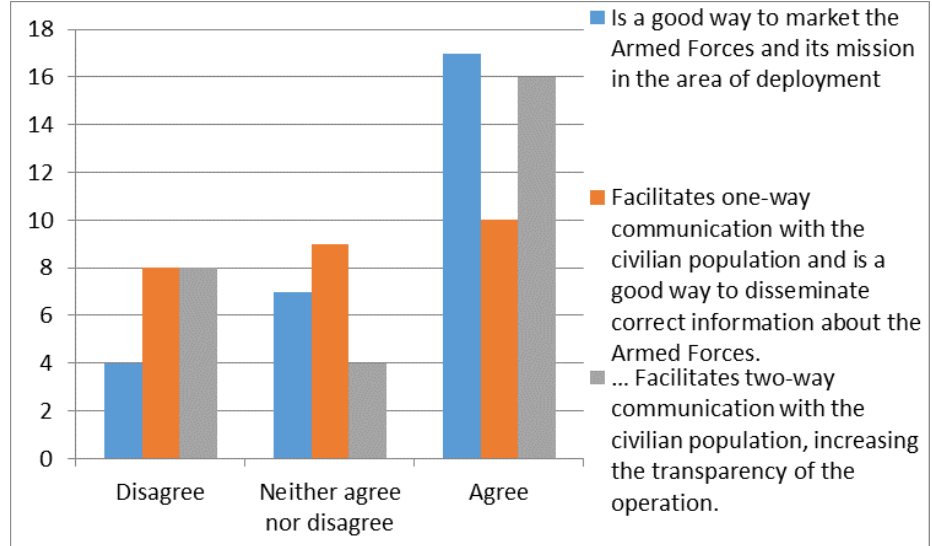
Figure 3. Opportunities with using social